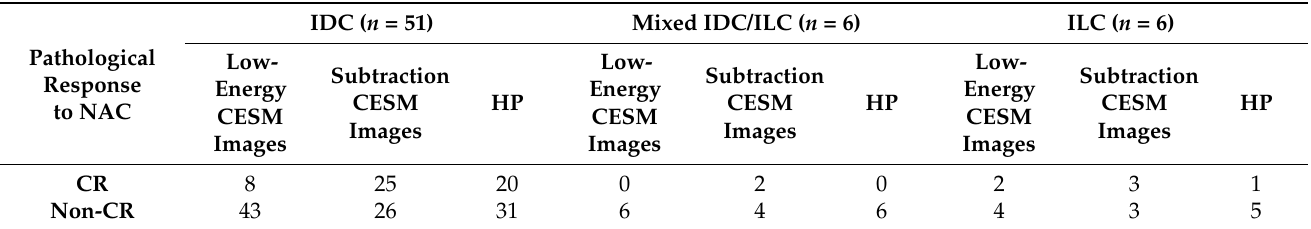
Table 4. Differences in NAC response depending on the type of breast cancer.